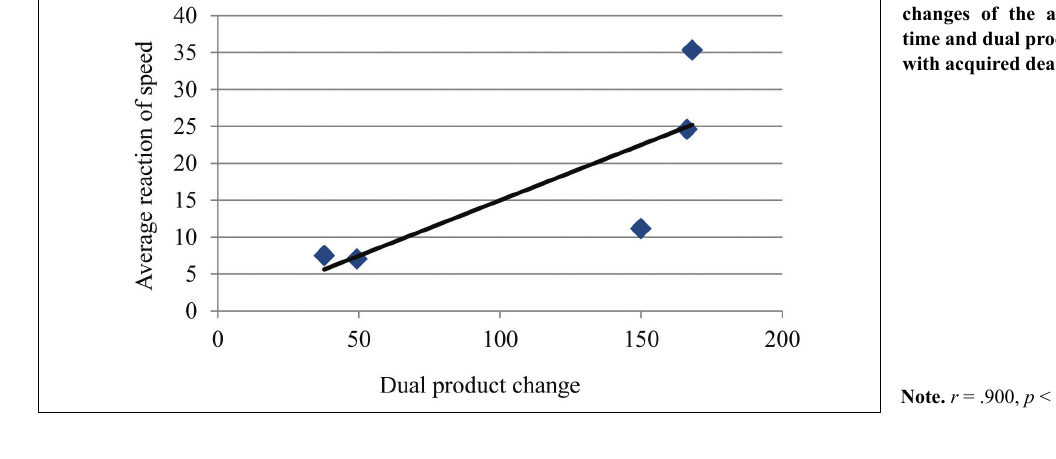
Figure 3. Simple reaction time of the research and control